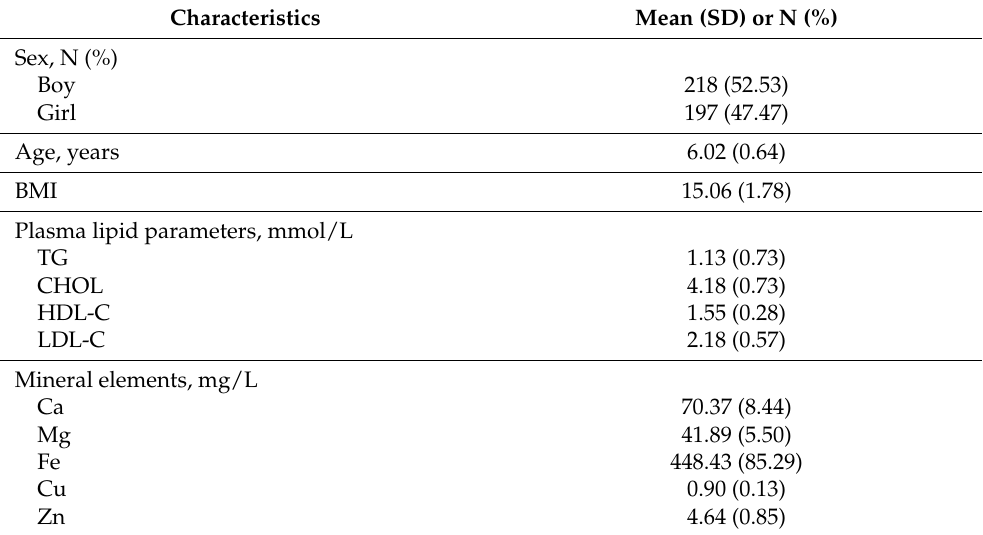
Table 1. Baseline characteristics of children ( n = 415).